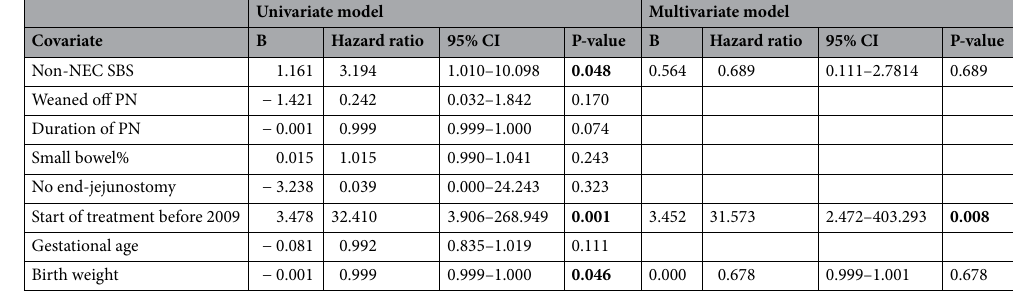
Table 4. Cox regression analysis for presence of histological IFALD at 10 years. Significant values are in bold. NEC necrotizing enterocolitis, SBS short bowel syndrome, PN parenteral nutrition, small bowel % age-adjusted small bowel